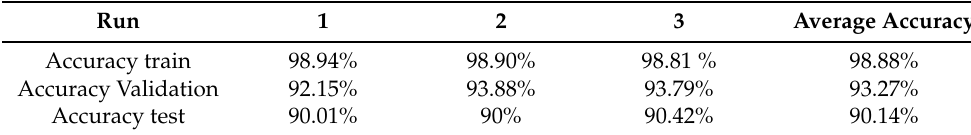
Table 9. Average accuracies of training, validation and testing of 7 electrodes with